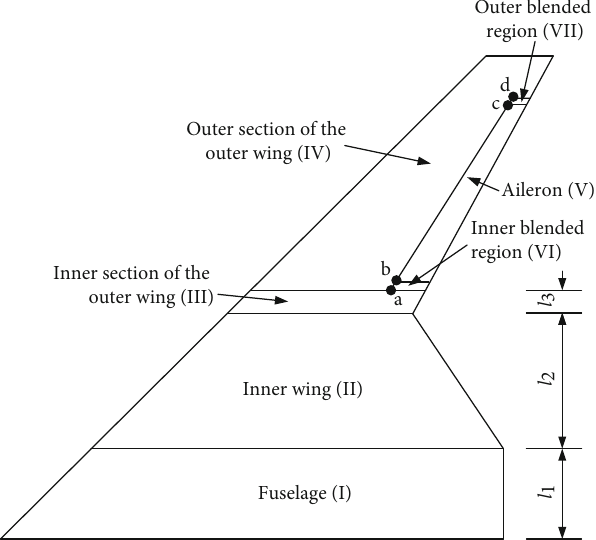
Figure 2: Division of the folding wing.